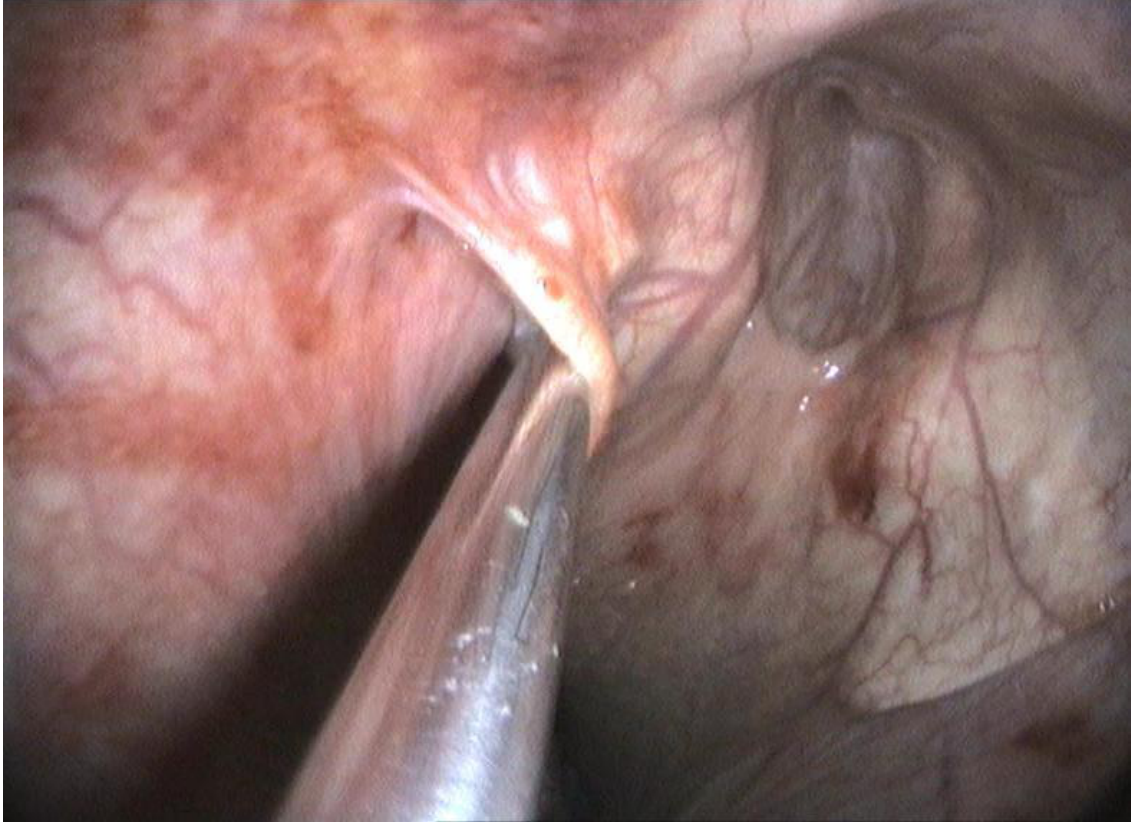
Figure 2: Endoscopic appearance of the pharynx showing the appearance of the Nielson catheter within the horse’s right guttural